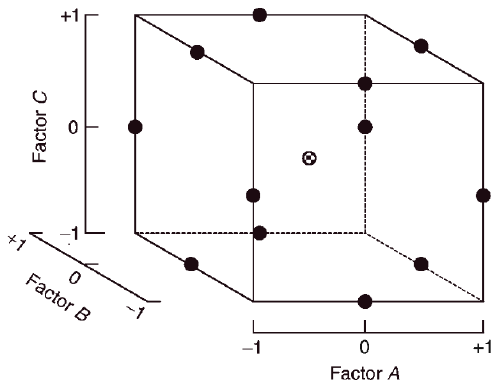
Figure 2. Box-Behnken design space for three factors